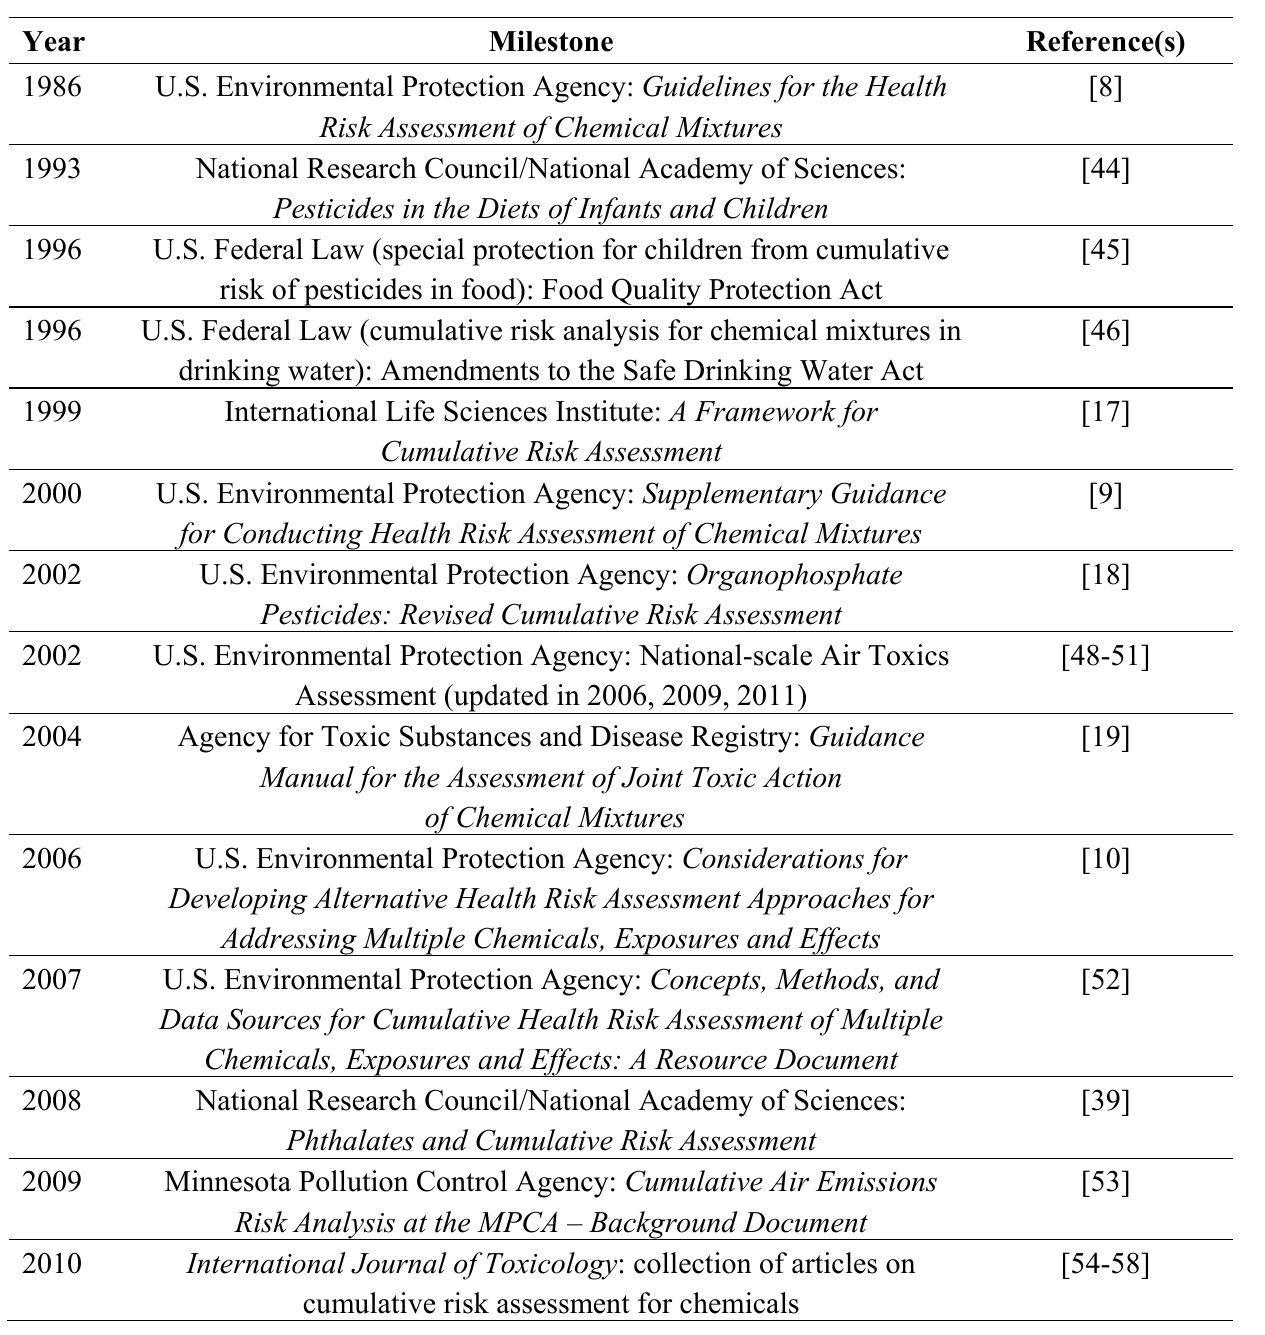
Table 1. Selected U.S. Milestones in the Evolution of Cumulative Risk Assessment for Health Effects from Exposure to Chemical